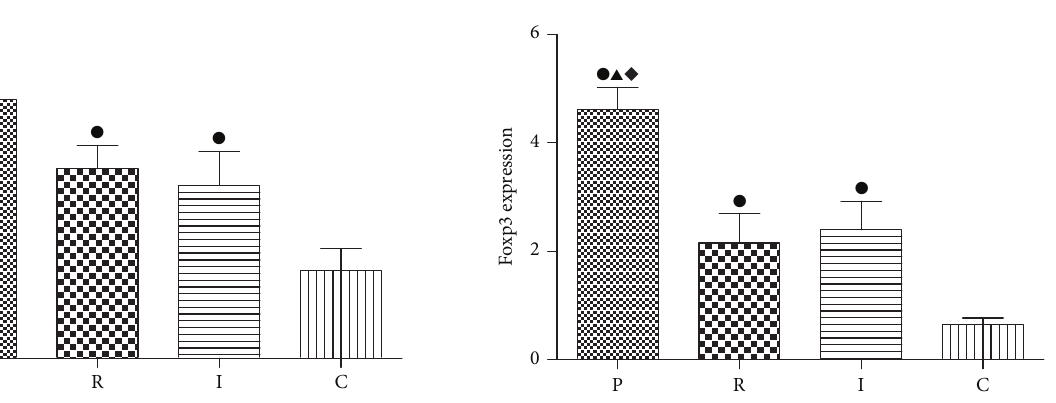
Figure 3: Total cell counts in BAL fluid on the seventh day. PAO1 group (P), Δ lasI Δ rhlI group (I), Δ lasR Δ rhlR group (R), and control group (C). e : compared with control group, 𝑝 < 0.05 . 󳵳 : statistically significant differences between PAO1 and Δ lasR Δ rhlR group, 𝑝 < 0.05 . X :statisticallysignificantdifferencesbetweenPAO1 and Δ lasI Δ rhlI group, 𝑝 < 0.05 .